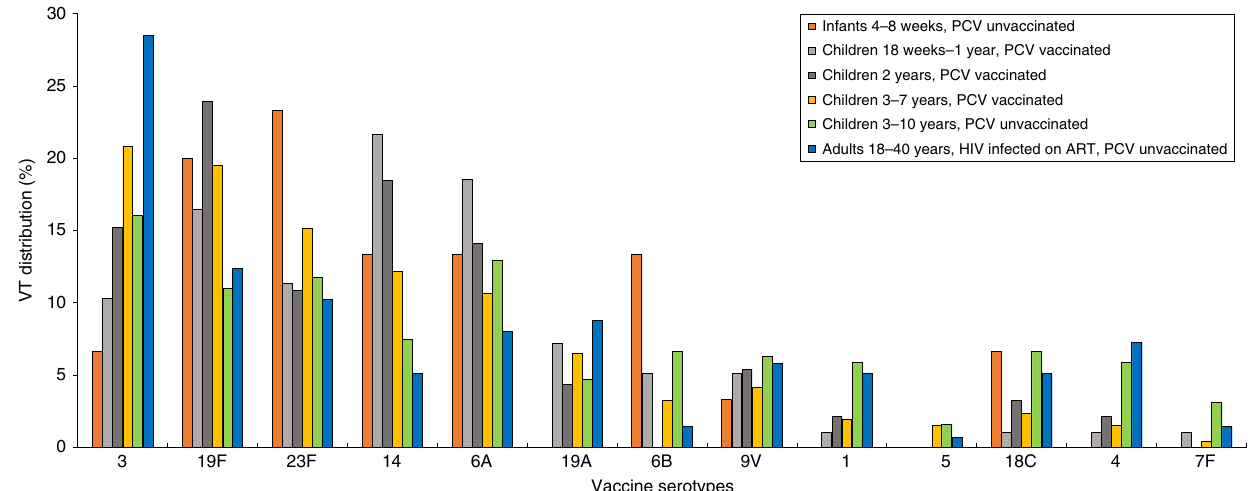
Fig. 3 Distribution of vaccine-serotype (VT) carriage, aggregated across study period and strati fi ed by study group. Proportion of VT carriage attributed to individual VTs across all surveys, strati fi ed by study group. The denominator for each serotype is the total VT isolates in each study